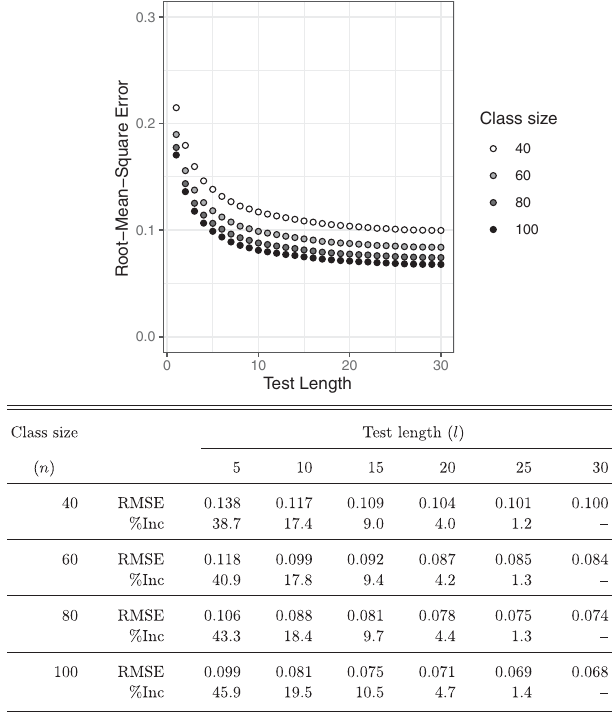
FIG. 7. The root-mean-square error of Cohen ’ s d as a function of testlengthofthe FCI-CAT, ascalculatedbyMonte Carlo simulation [class size ¼ ð 40 ; 60 ; 80 ; 100 Þ , sample size ¼ 10000 classes]. The true value of Cohen ’ s d is 0.38. The values in the table are characteristic points plotted in the graph. The percent increase of the RMSE from the full-length test is denoted by